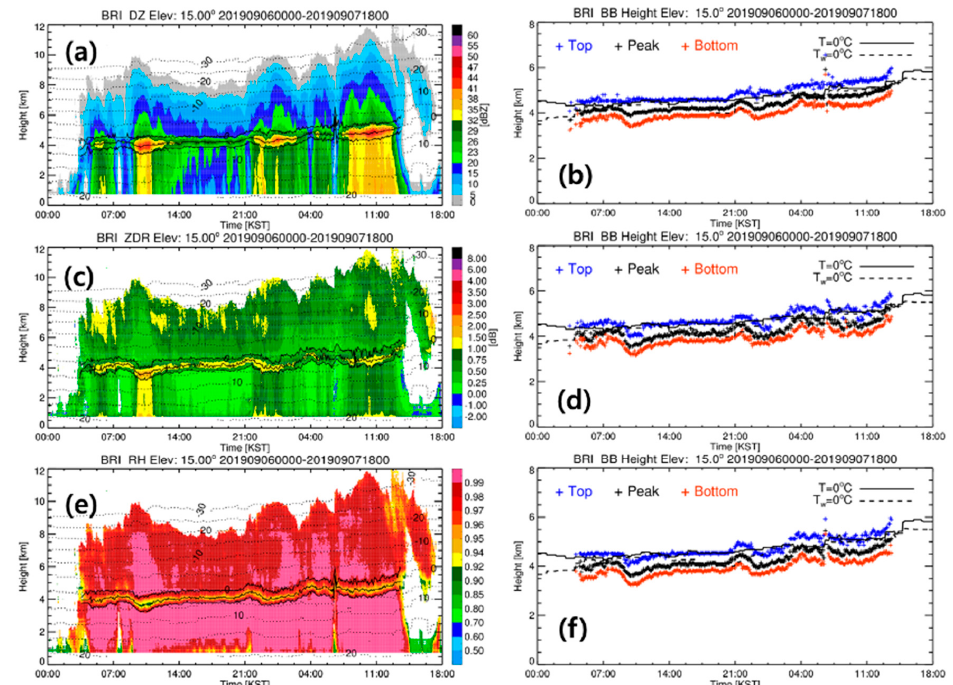
Figure 3. Time series of quasi-vertical profiles (QVPs) of the ( a ) Z H , ( c ) Z DR , and ( e ) ρ HV and the height of the top (blue), peak (black), and bottom (red) of the BB from the ( b ) Z H , ( d ) Z DR , and ( f ) ρ HV at elevation angles of 15.0° of the BRI radar from 0000 KST of 6 September 2019 to 1800 KST of 7 September 2019. The solid and dashed lines indicate the heights where T is 0 °C and T w is 0 °C, respectively.